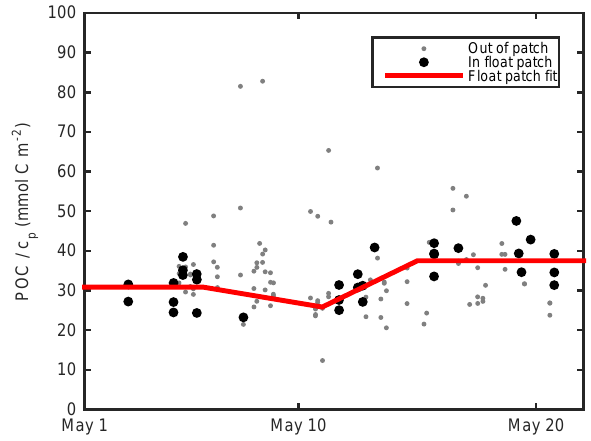
Figure 2. POC /c p from the May cruise in the upper 30m and the fit used to calculate POC cp